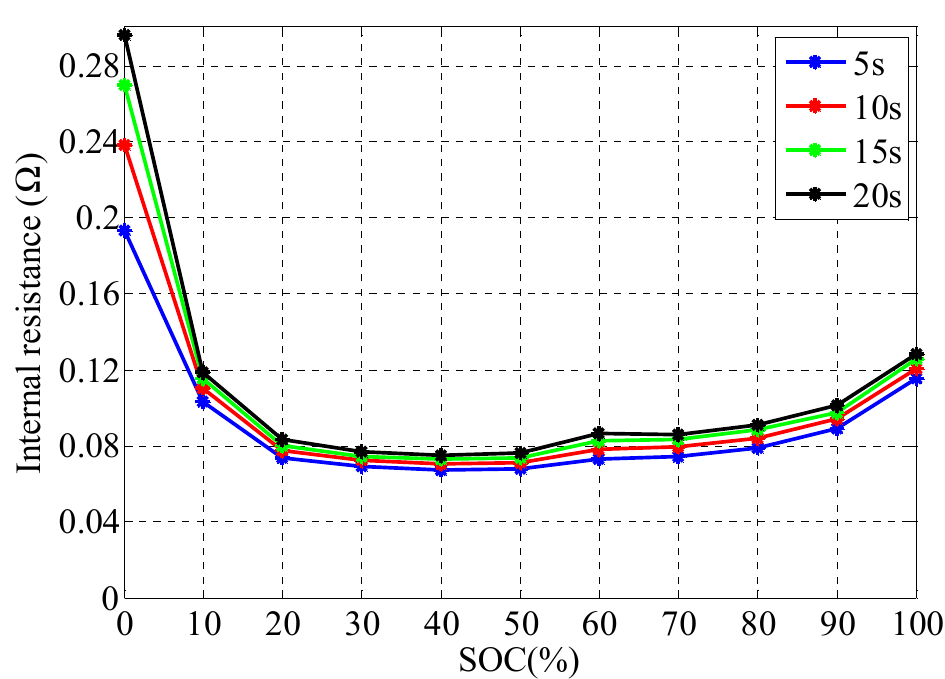
Figure 2. DC resistance measured at different SOCs for Li(NiCoAl)O 2 based cells using C/2 dis- charge.